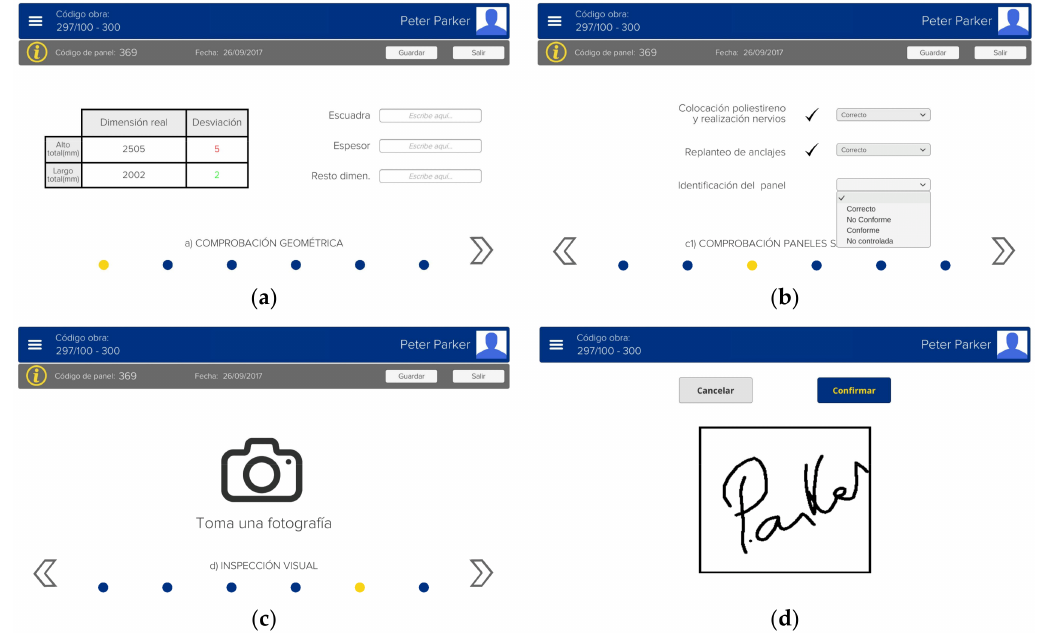
Figure 4. Examples of windows of the interface layer, for the item “manufacture of GRC panels”: ( a ) geometric checking, where the inspector can insert numeric values; ( b ) panels checking, where the inspector can choose one option from drop-down menus; ( c ) visual inspection, where an image can be taken; and ( d ) signature, where the inspector can give the conformity to the inspection process by hand-signing it.